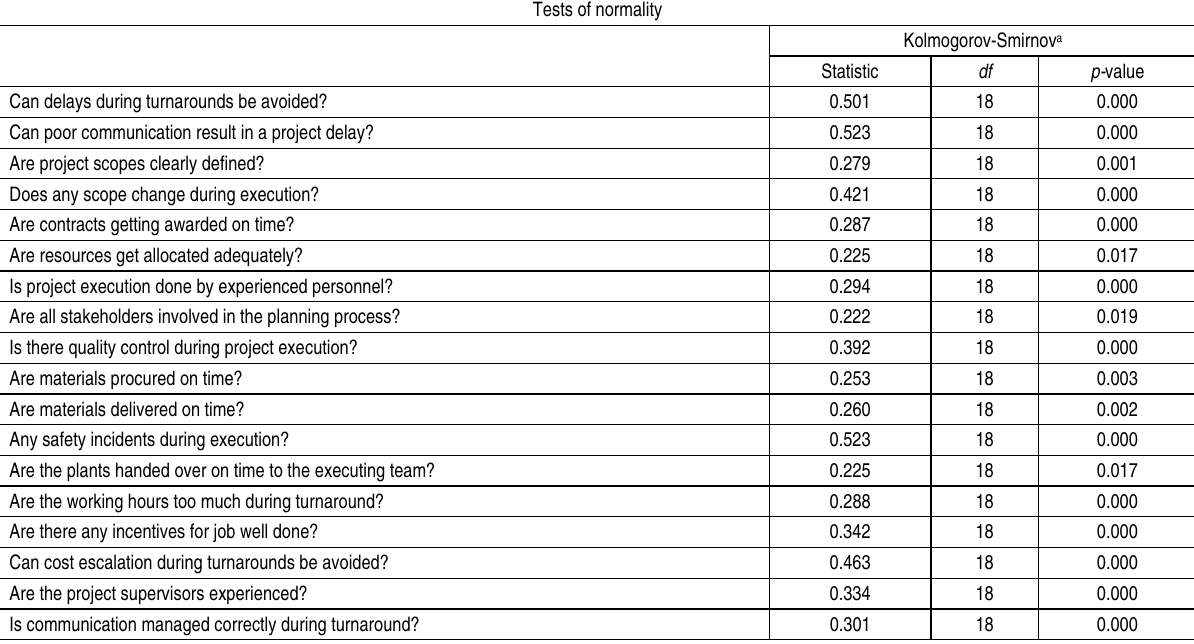
Table 2. Kolmogorov-Smirnov Z test for